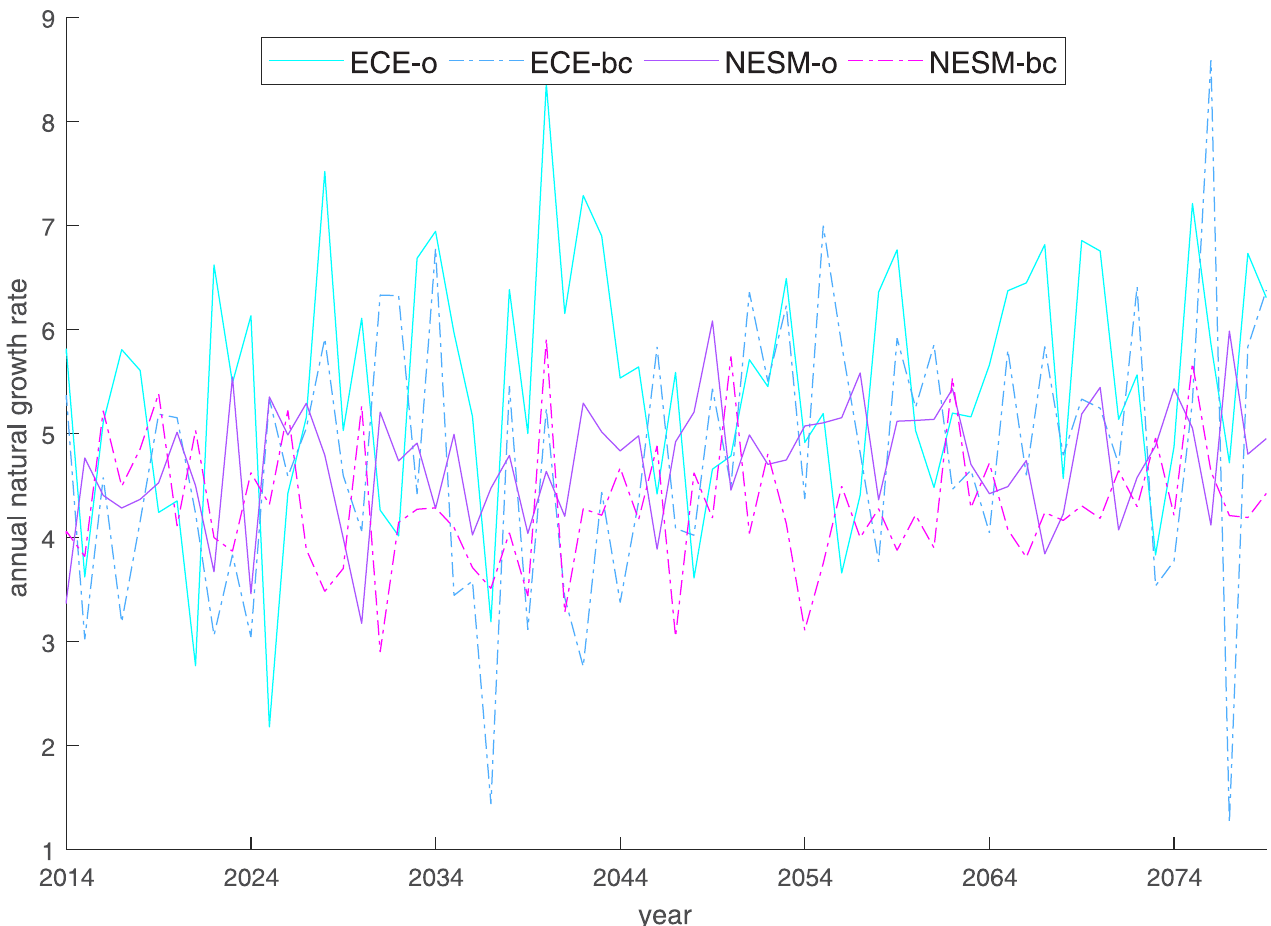
Fig 4. Annual climate affected natural growth rate r + f ( UP